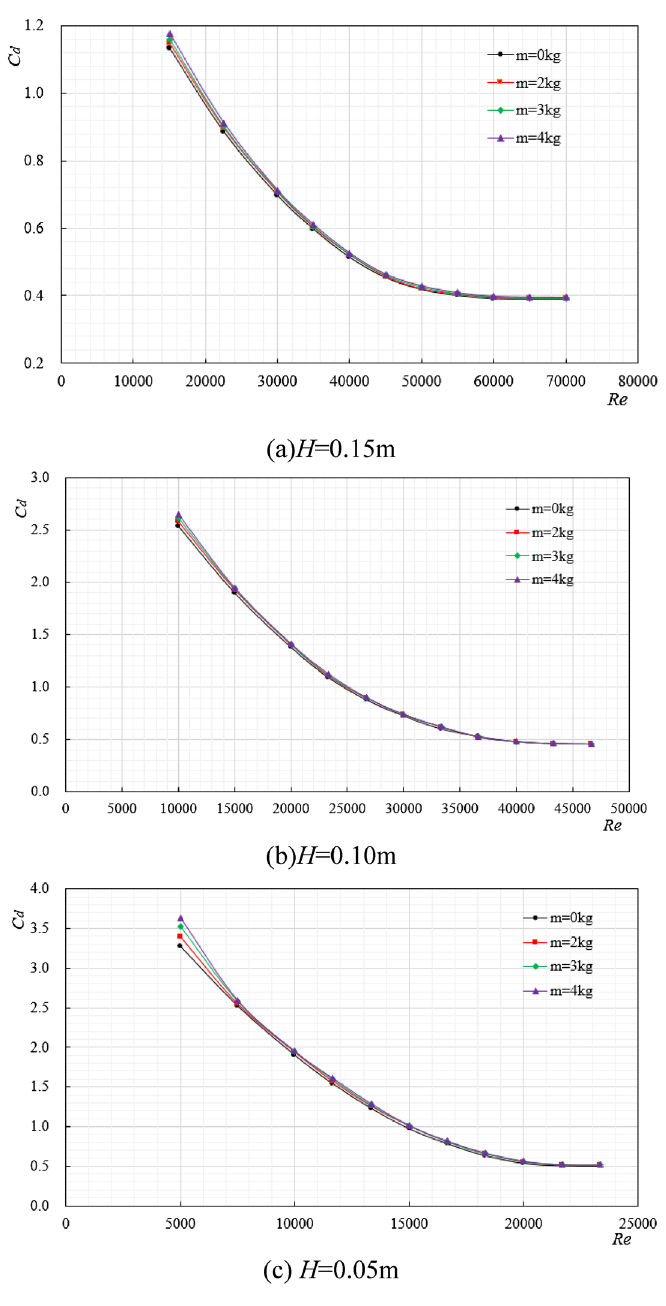
Figure 10. The variation law diagram of resistance coefficient of cylindrical ore bin under different additional (3) When the characteristic length and excitation displacement are the same, the resistance coefficient of the cylindrical shape is greater than that of the rectangular shape, the design of the ore bin shape should not only meet the requirements of reducing the longitudinal vibration, but also meet the standard of keeping the offset distance as small as possible in the transverse towing, so the shape of the ore bin in the actual design and production is designed to be cylindrical. (4) For the same shape of the ore bin, changing the added weight at a high Reynolds number (Re ≥ 20,000) will not change the resistance coefficient of the ore bin, while increasing the added weight at a low Reynolds number will increase the resistance coefficient.